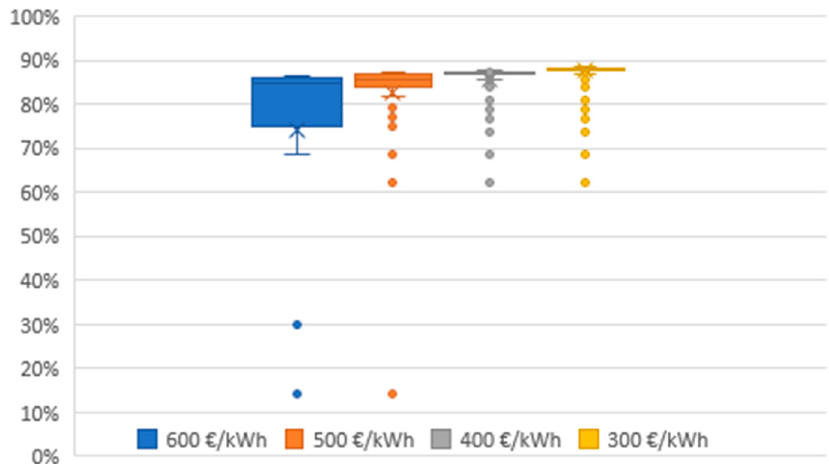
Figure 21. Box and whisker plot of the median value of the electrochemical storage SoC ES , depending on the ES unitary cost.